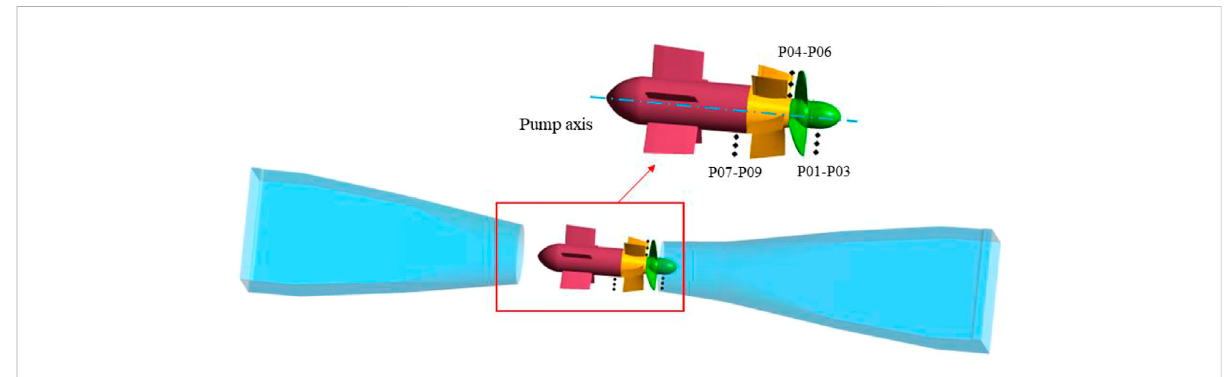
Schematic diagram of the pressure pulsation monitoring